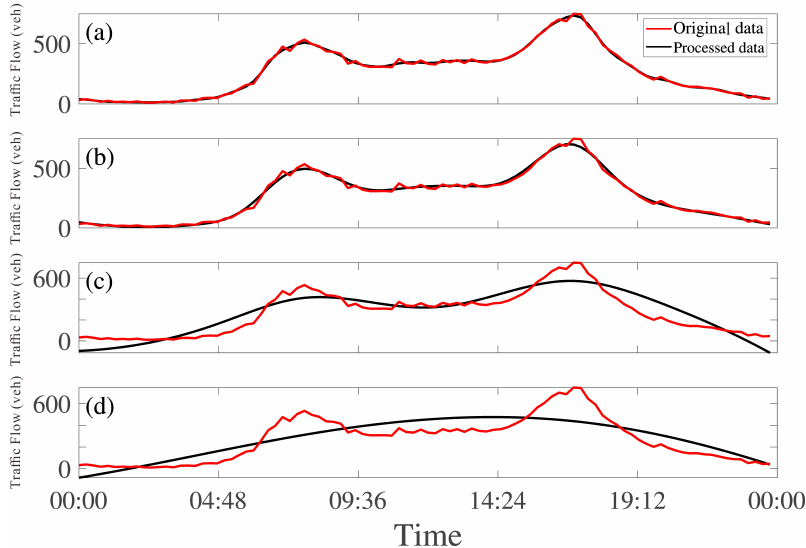
Figure 10. Comparison of raw tra ffi c flow data and reconstructed data from ( a ) IMF2 to Residuals; ( b ) IMF3 to Residuals; ( c ) IMF4 to Residuals; ( d ) IMF5 to